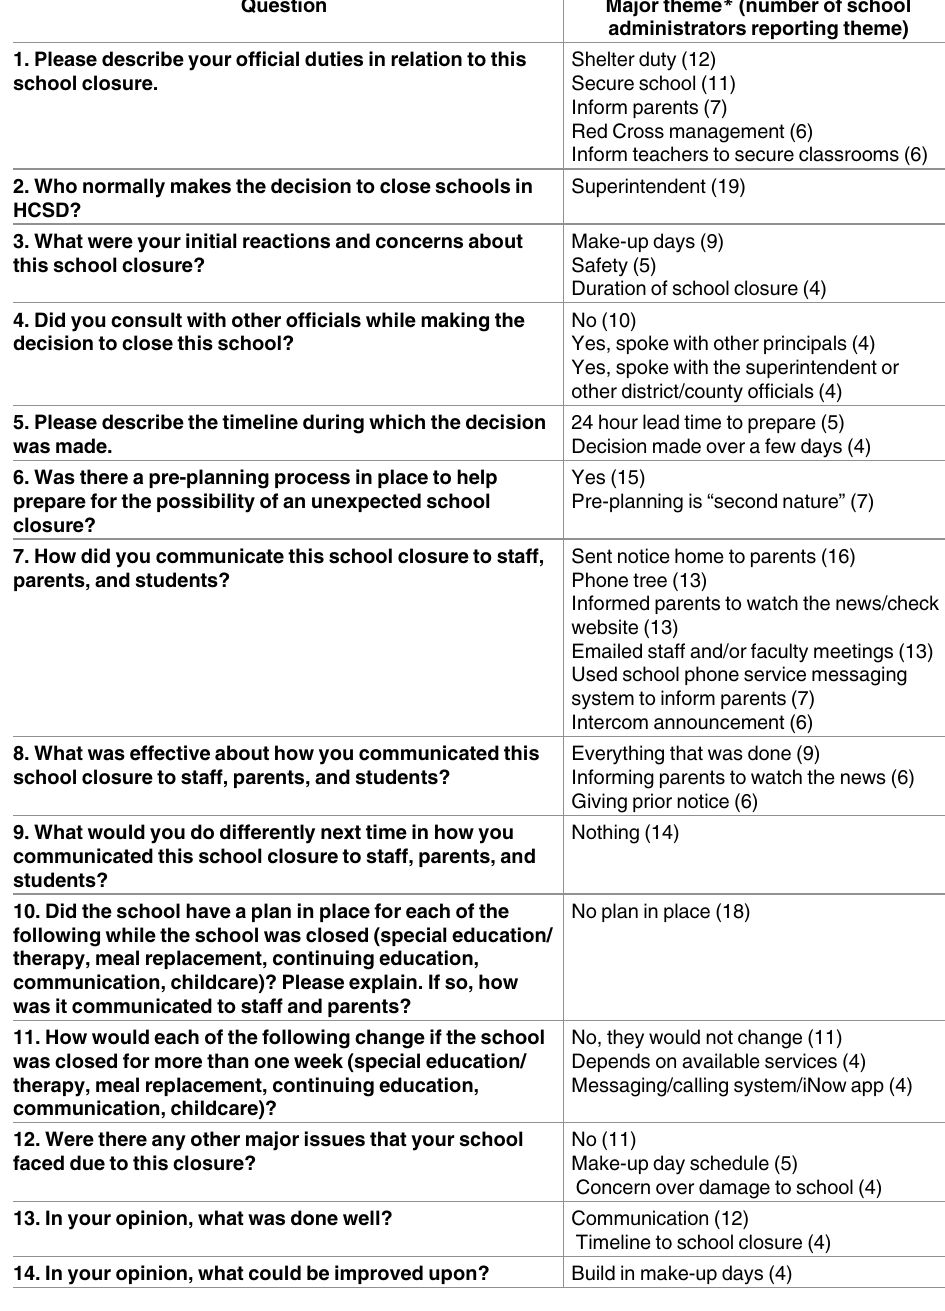
Table 8. School administrator interviews: Major themes reported by principals and vice-principals (N = 20). HarrisonCounty School District, Mississippi, August 2012.